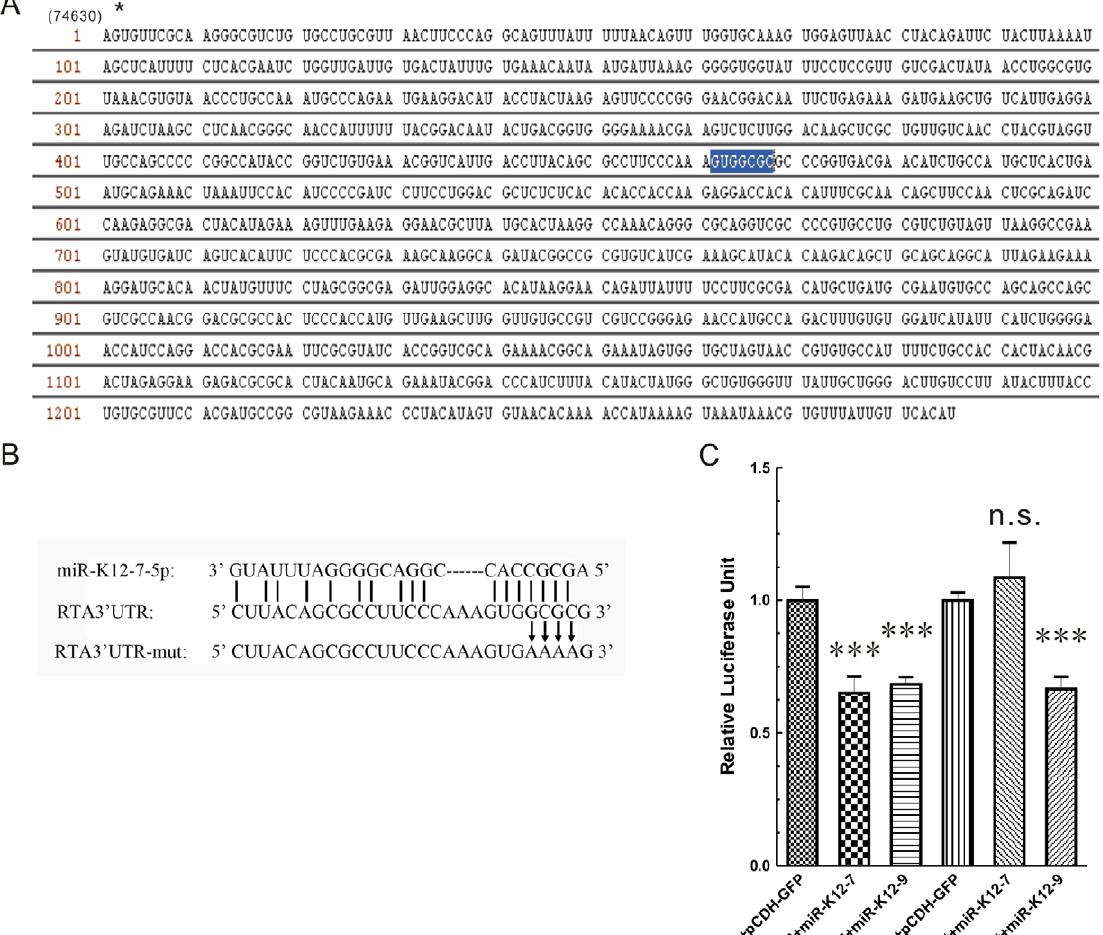
was also observed (Figure 3A). Quantification of these effects from three independent experiments (Figure S3) indicated that among these miRNAs, miR-K12-7 repressed RTA expression most significantly, by . 45% (Figure 3B; analyzed with NIH ImageJ).